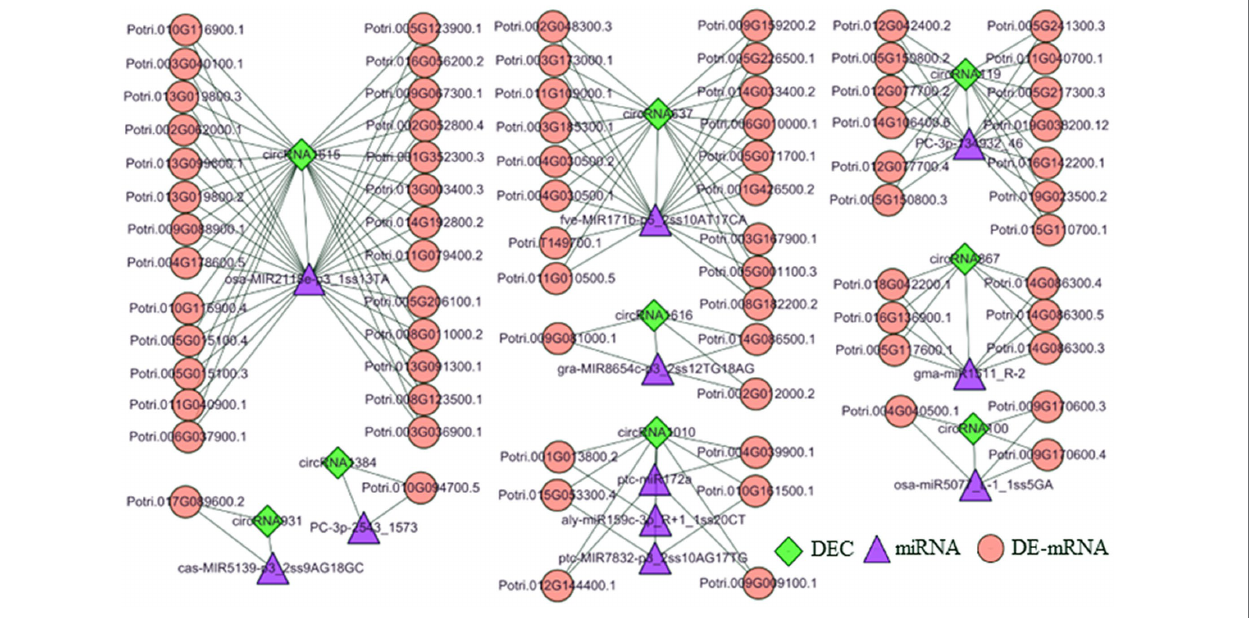
FIGURE 4 | The DEC–miRNA–DEmRNA networks in the roots of P. × canescens treated with Tl, T2 and T3. Diamond, triangle, and circular nodes represent circRNAs, miRNAs, and mRNAs,